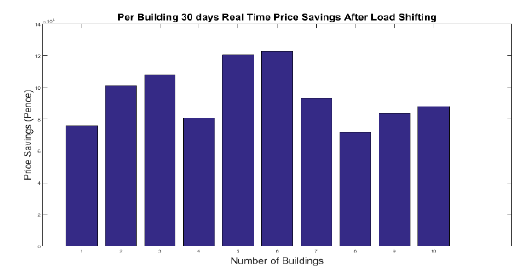
Figure 12. Monthly real-time price reduction in terms of traditional price after load shifting.